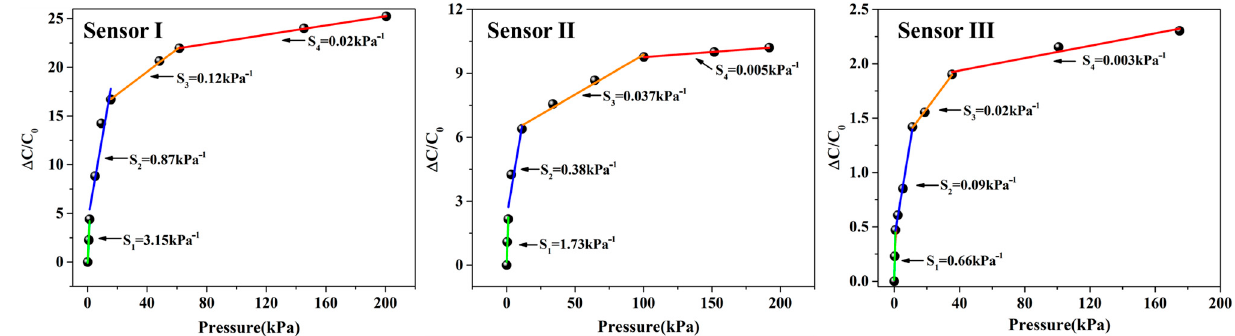
Figure 8. The function of segmented linear fitting.